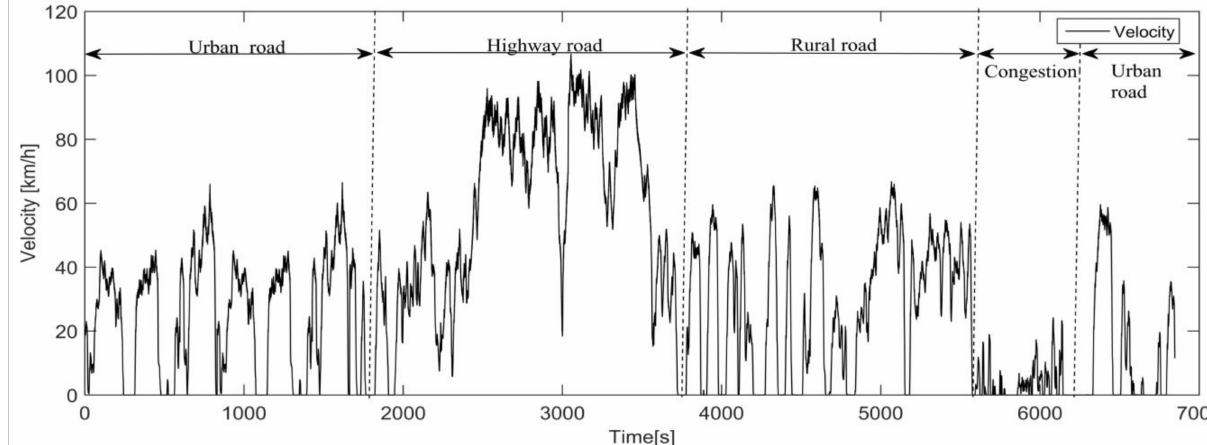
Figure 11. The driving circle of a private car in Beijing.